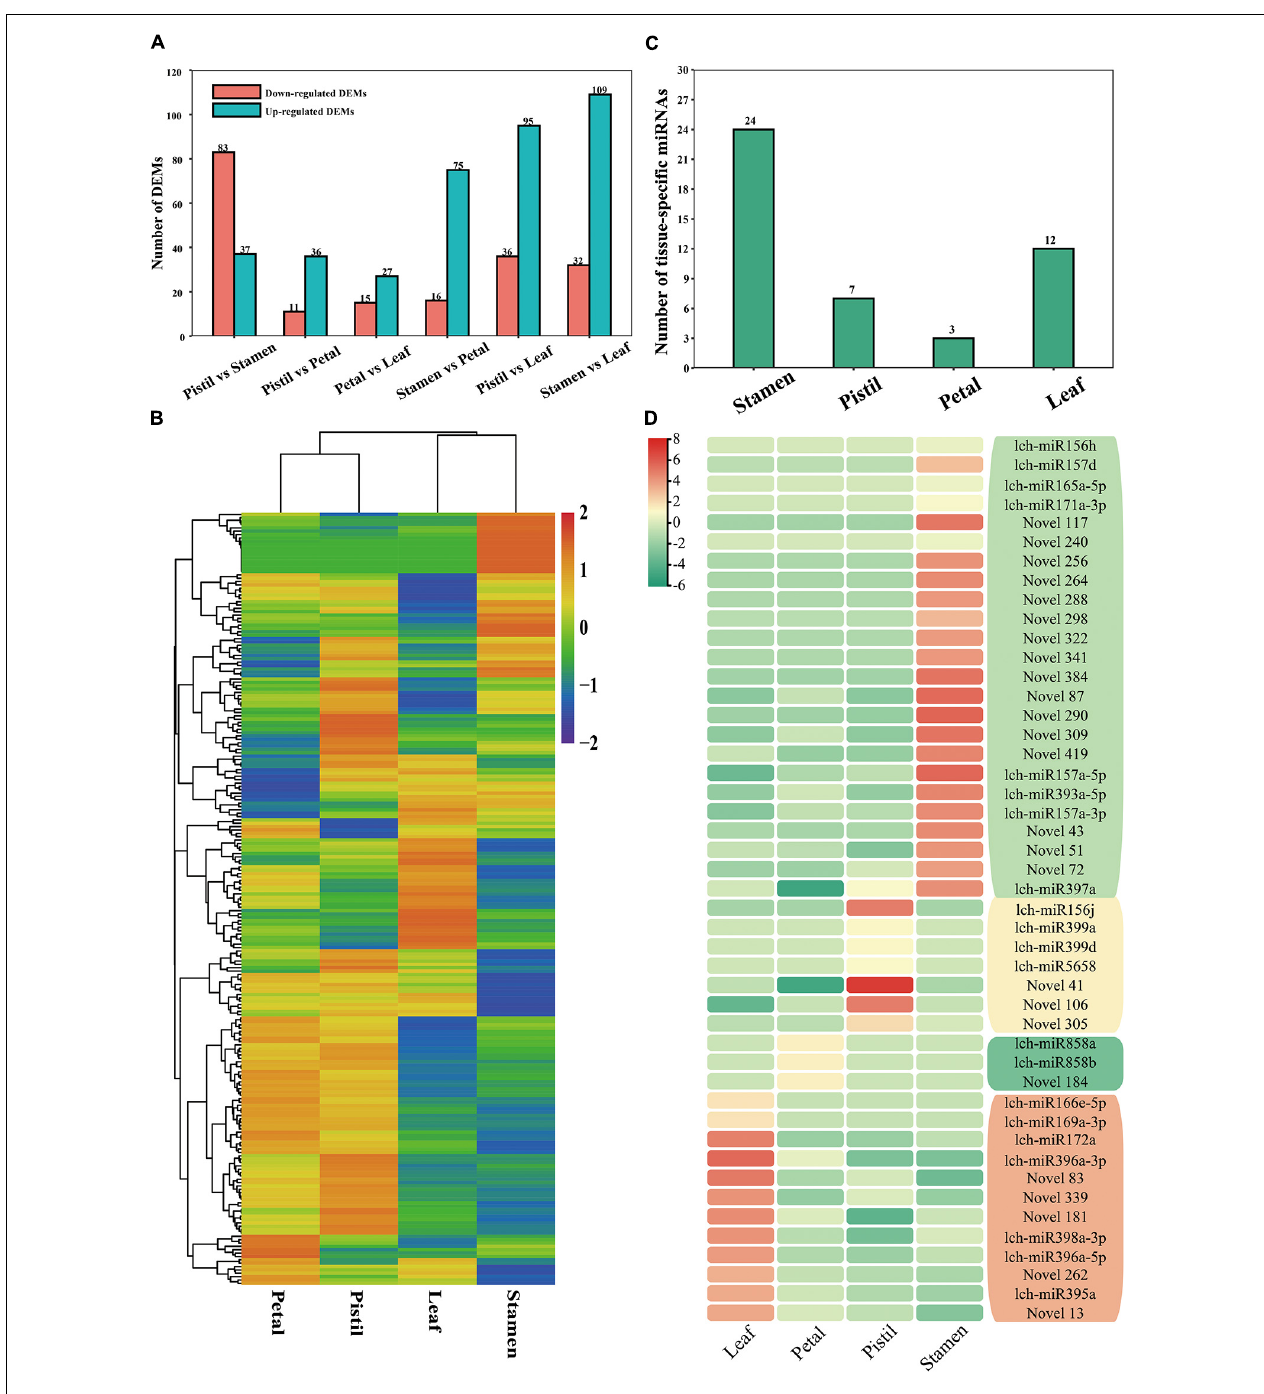
FIGURE 3 | Information on the differentially expressed miRNAs (DEMs) and miRNAs with relatively high expression level in L. chinense . (A) The number of DEMs between different tissues. (B) Hierarchical cluster analysis of DEMs. Log2(TPM + 1) values of DEMs were used for the hierarchical cluster analysis. (C) The number of highly expressed miRNAs in L. chinense . (D) Heat map of highly expressed miRNAs. Log2(TPM + 1) values of highly expressed miRNAs were used to construct the heat